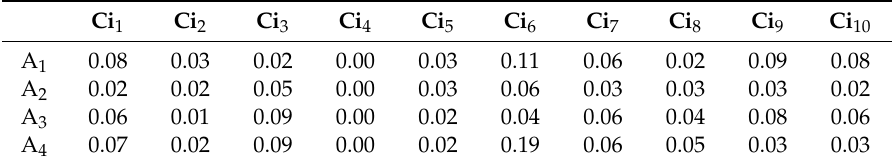
Table 20. The weighted values of the judgments matrix.